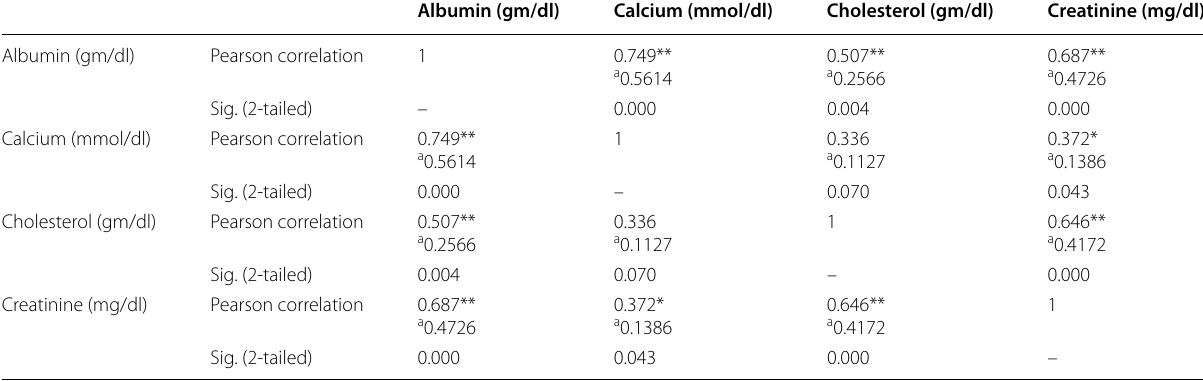
** Correlation is significant at the 0.01 level (2-tailed) * Correlation is significant at the 0.05 level (2-tailed) a R 2 value was obtained from the